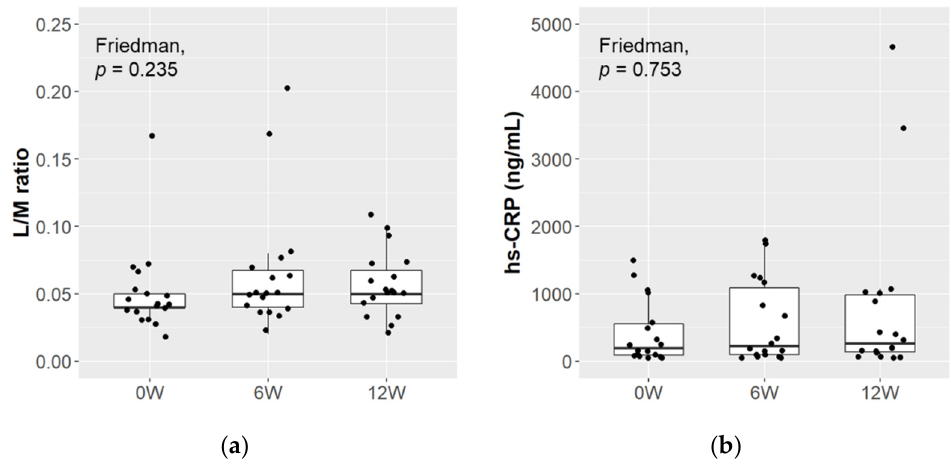
Figure 4. Changes in the markers of intestinal permeability and inflammation. The L/M ratio ( a ) and hs-CRP level ( b ) were measured to evaluate intestinal permeability and inflammation, respectively ( n = 18). The Friedman test was used for the multiple comparisons between time points.